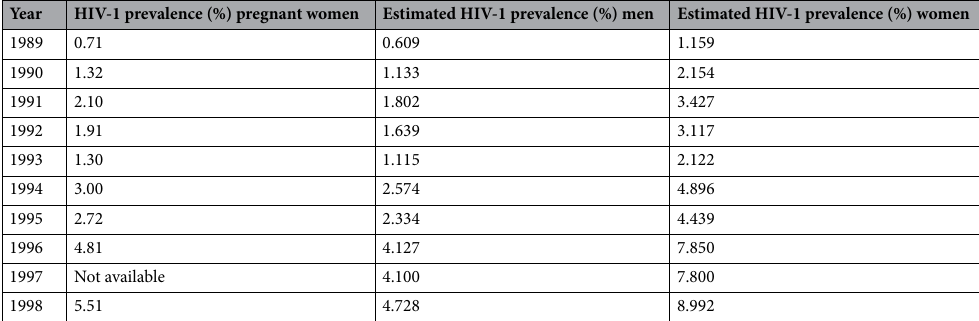
Table 3. HIV-1 prevalence data for Yaoundé’s pregnant women. Source US Census Bureau, 2001, HIV/AIDS Profile, Cameroon, HIV/AIDS Surveillance Database 22 (confidence interval and sample size not available) (second column). Third and fourth column: Estimated HIV-1 prevalences for Yaoundé’s men and women, that were used as model calibration targets in this